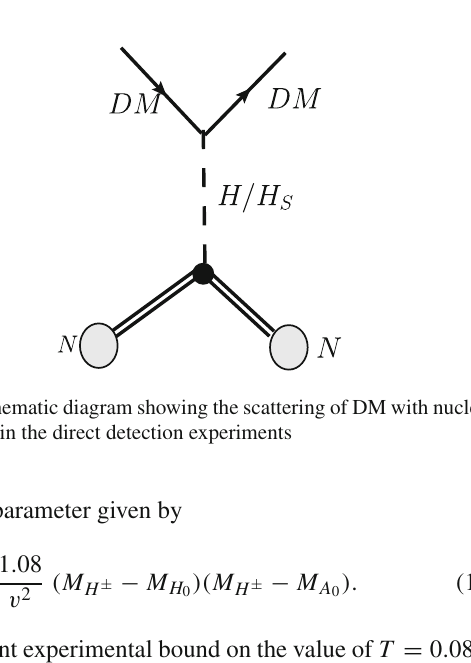
Fig. 1 Feynman rules relevant to the annihilation of the DM candidates